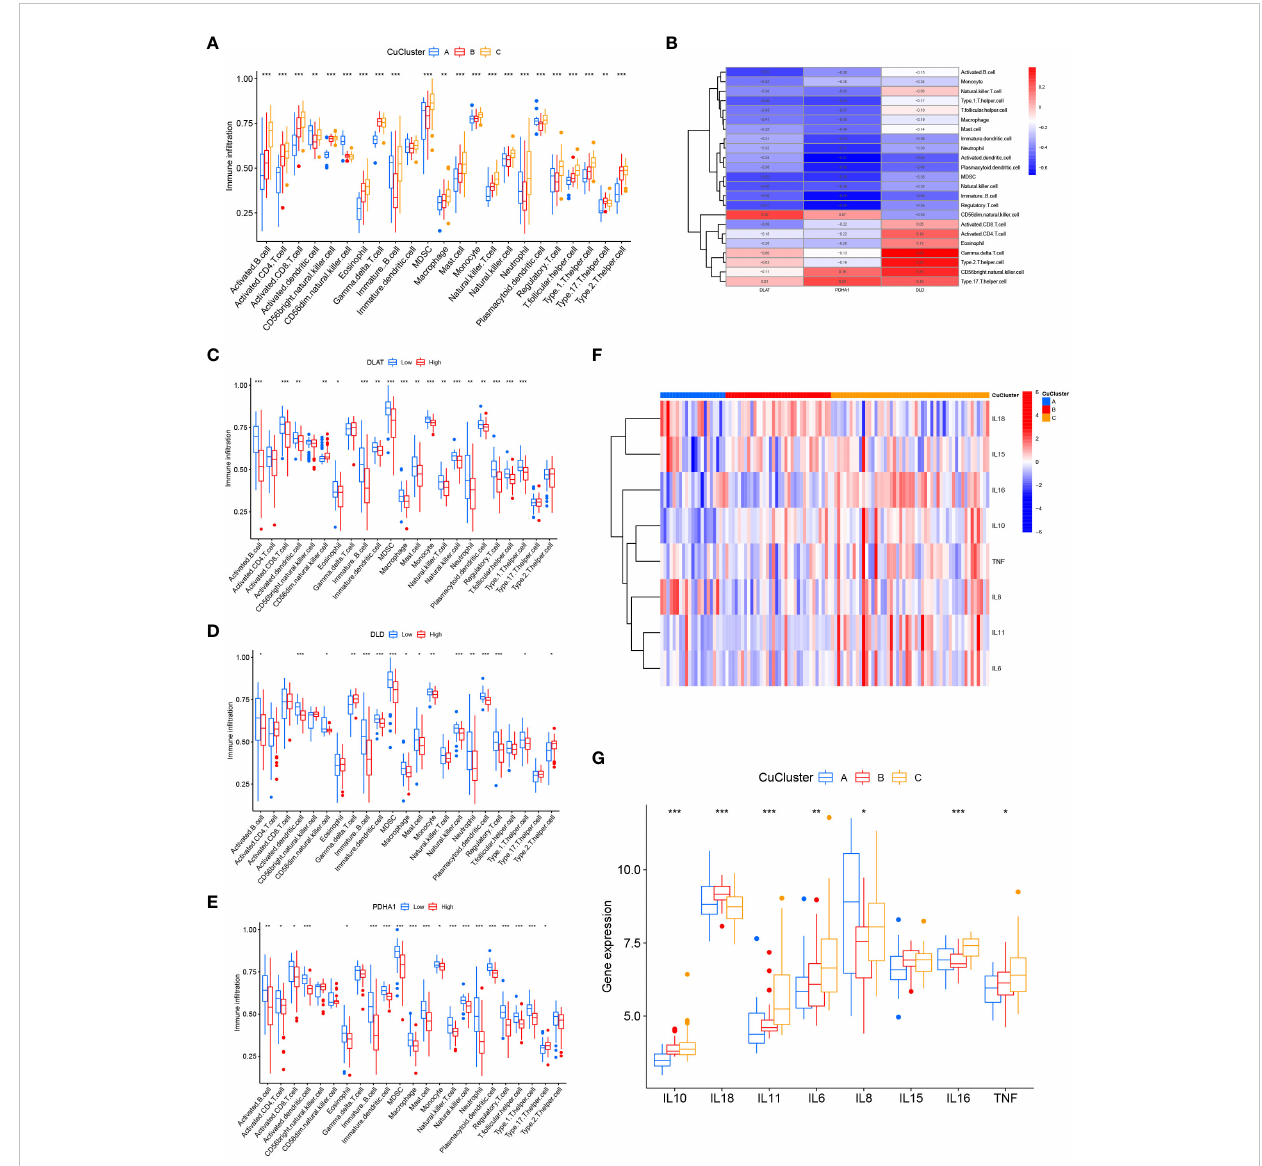
FIGURE 3 Consensus clustering of hub genes associated with cuproptosis in ulcerative colitis patients. (A) Differences in immune cell in fi ltration among CuClusterA, CuClusterB, and CuClusterC. (B) Correlation of three cuproptosis-related genes with mucosal immune cells. (C – E) Correlation between high and low expression of DLAT (C) , DLD (D) , PDHA1 (E) , and mucosal immune cells. (F, G) Differences in in fl ammatory factors among CuClusterA, CuClusterB, and CuClusterC. CuClusterA, cuproptosis-ClusterA; CuClusterB, cuproptosis-ClusterB; CuClusterC, cuproptosis-ClusterC. The asterisk represents the statistical p -values (* p < 0.05; ** p < 0.01; *** p <